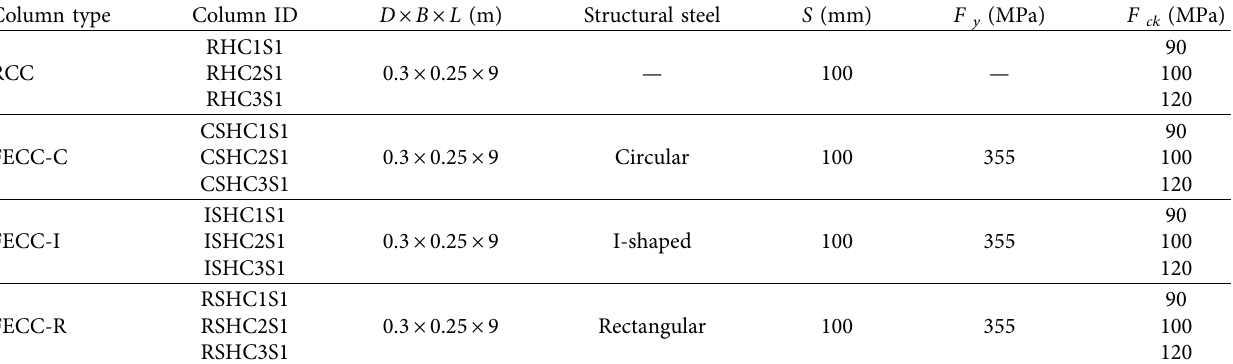
Table 5: Specimens for efects of concrete compressive strength.